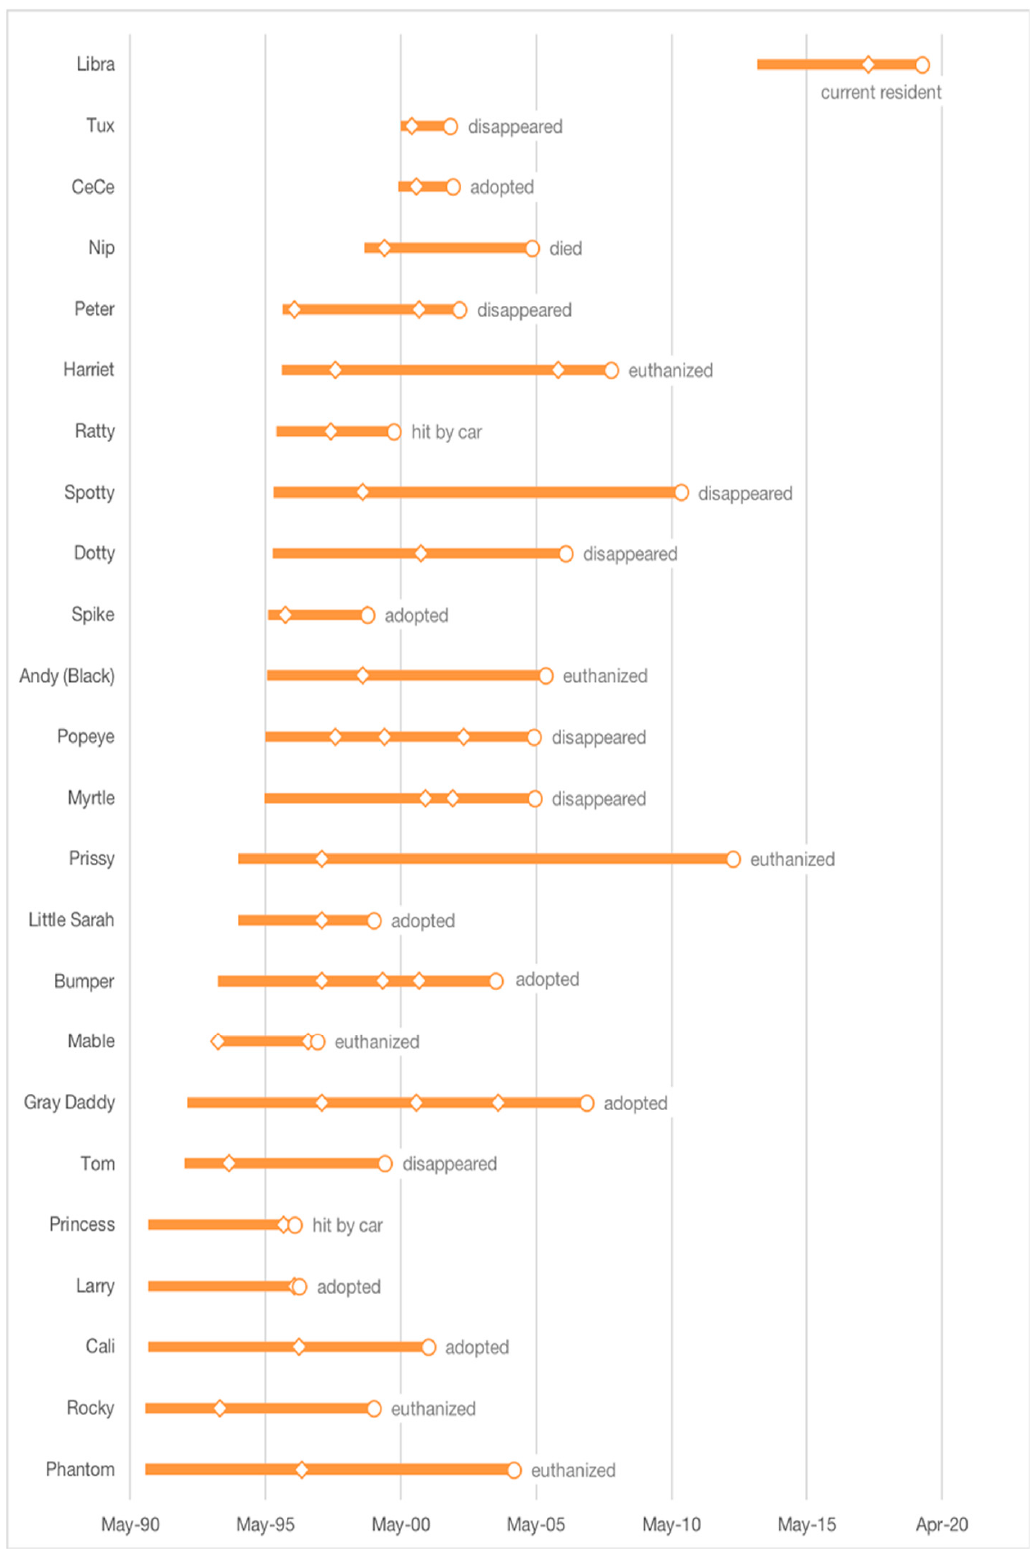
Figure 4. Timing of arrival and disposition of cats who changed colonies over the 28-year observation period. Diamonds indicate time of colony change(s); circles indicate time of disposition.